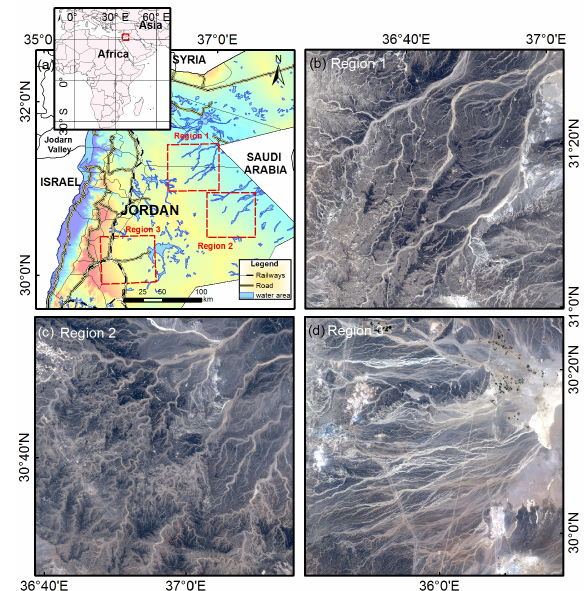
Figure 1. ( a ) Locations of the three study areas in Jordan; ( b ) true-color image (432 band for OLI) of Study Area 1; ( c ) true-color image of Study Area 2; and ( d ) true-color image of Study Area